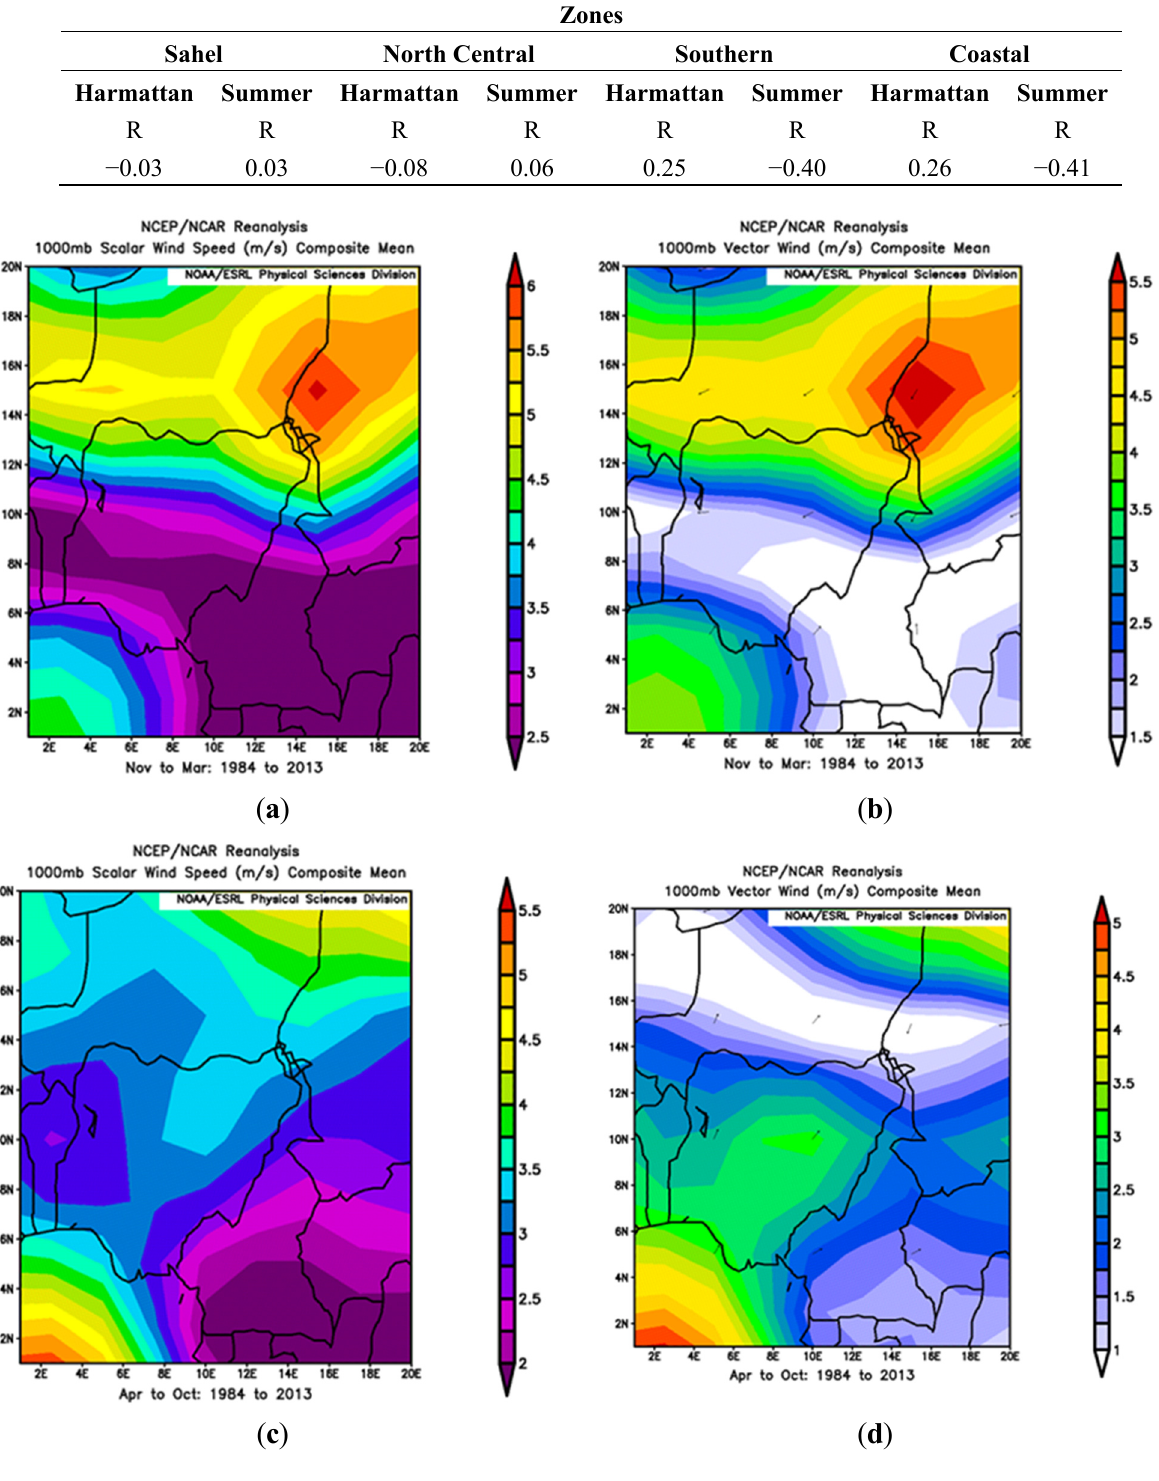
Figure 4. The 30-years mean speed and direction of Harmattan and Summer wind speed: ( a ) Harmpattan mean, ( b ) Harmattan direction, ( c ) Summer mean, ( d ) Summer direction. Fifth, the visibility values of the recent months of are lower from 2000 to 2013 compared to the month of previous years. This is evident of increase anthropogenic activities that increased the rate of